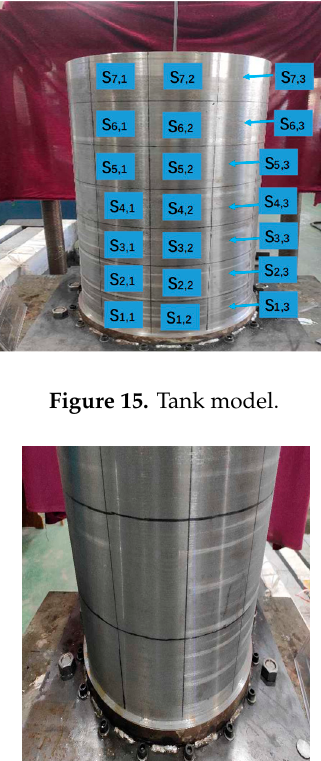
Figure 16. Fixed support.